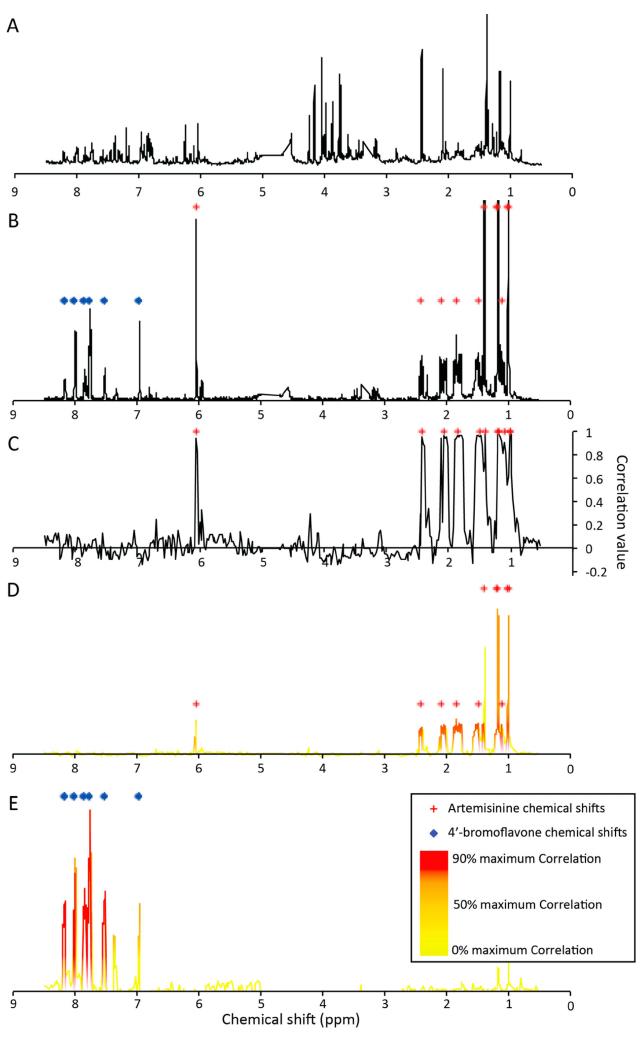
Figure 2. Example of statistical deconvolution on the coelution of artemisinin and 4 ′ -bromoflavone. ( A ) sum of all 80 1 H-NMR spectra; ( B ) sum of all 80 1 H-NMR spectra of fractions G9 to H10; ( C ) correlation 1 H-NMR pseudospectrum, corresponding to feature RT = 2.18 min and m/z = 283.1566 (PI)—artemisinin as [M + H] + adduct; ( D ) filtered 1 H-NMR pseudospectrum corresponding to feature RT = 2.18 min and m/z = 283.1566 (PI)—artemisinin as [M + H] + adduct; ( E ) filtered 1 H-NMR pseudospectrum corresponding to feature RT = 2.37 min and m/z = 300.9882 (PI)—4 ′ -bromoflavone as [M + H] + adduct; red crosses ( ` ) highlight chemical shifts detected for pure artemisinin; blue diamonds ( ♦ ) highlight chemical shifts detected for pure 4 ′ -bromoflavone.